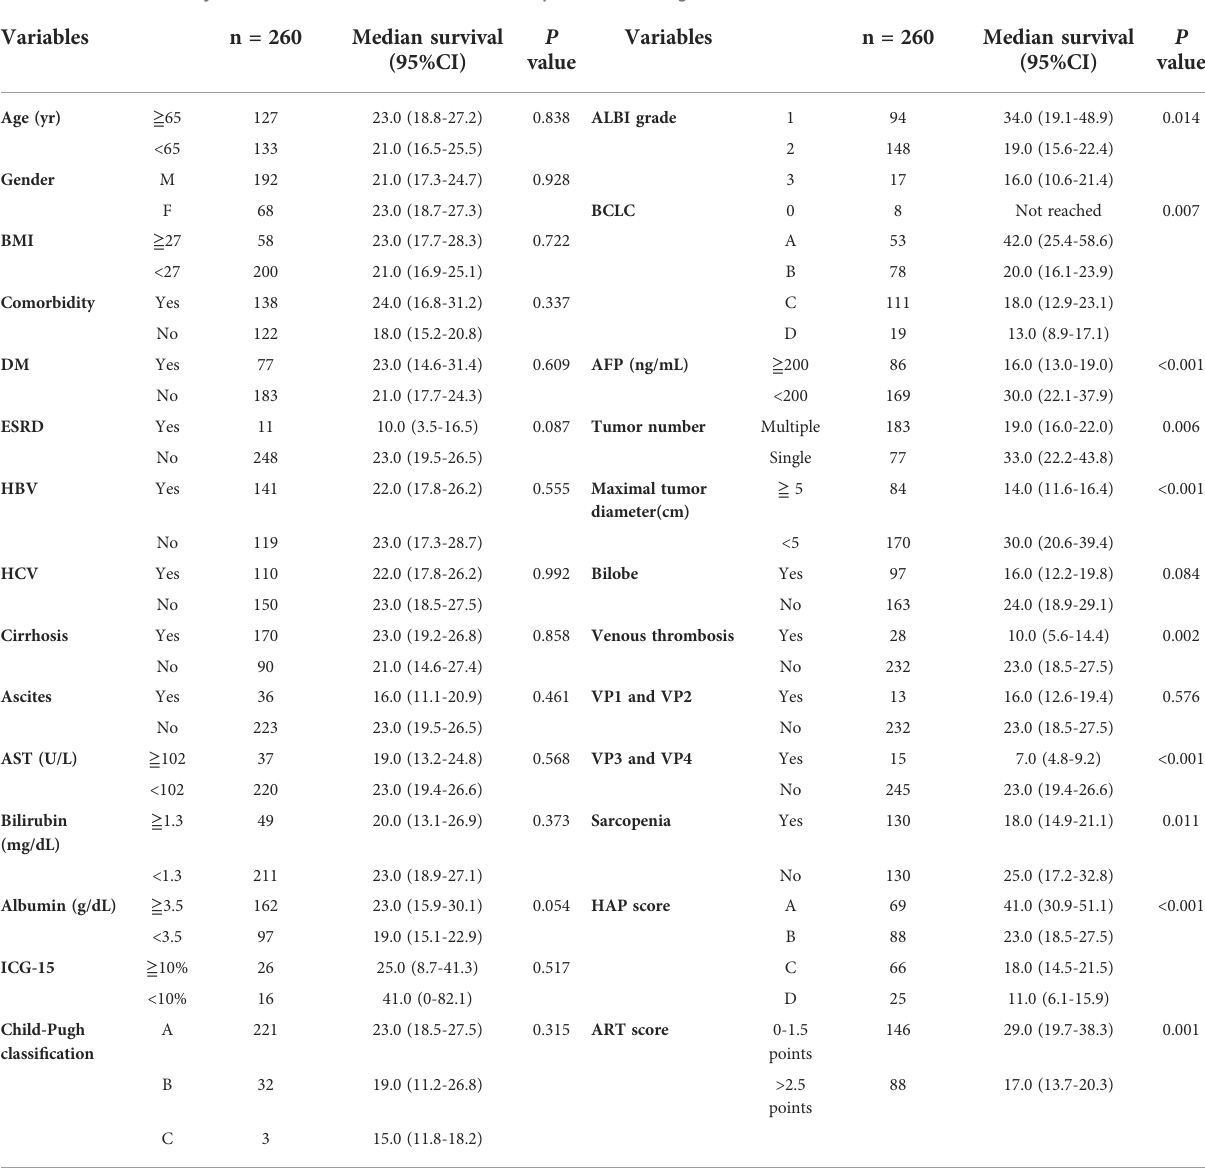
TABLE 3 Univariate analysis of factors for overall survival in HCC patients receiving TACE.